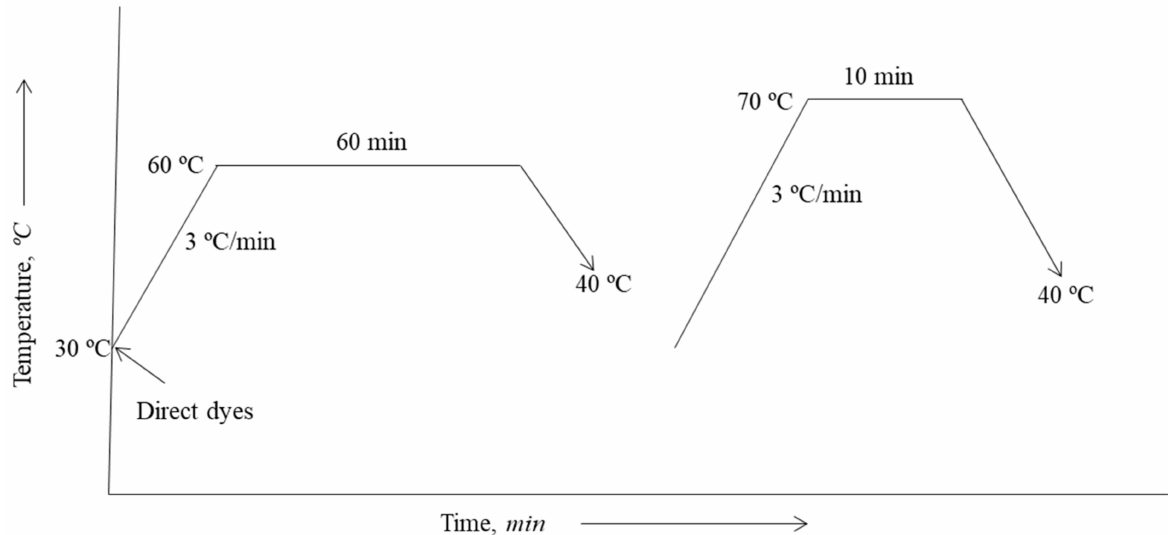
Figure 2. Process curve of direct